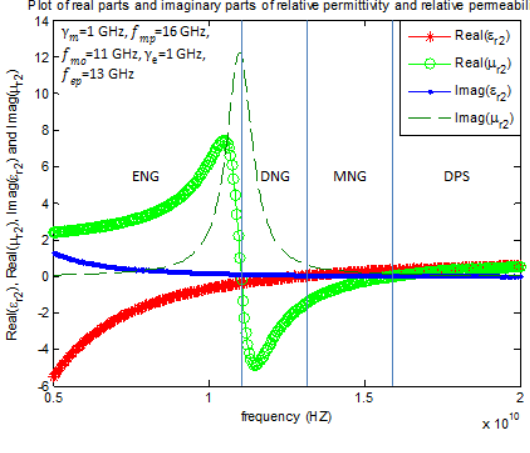
FIGURE 2. Real parts of relative permittivity, ε r2 , and permeability, µ r2 , of Rods and Rings media vs.